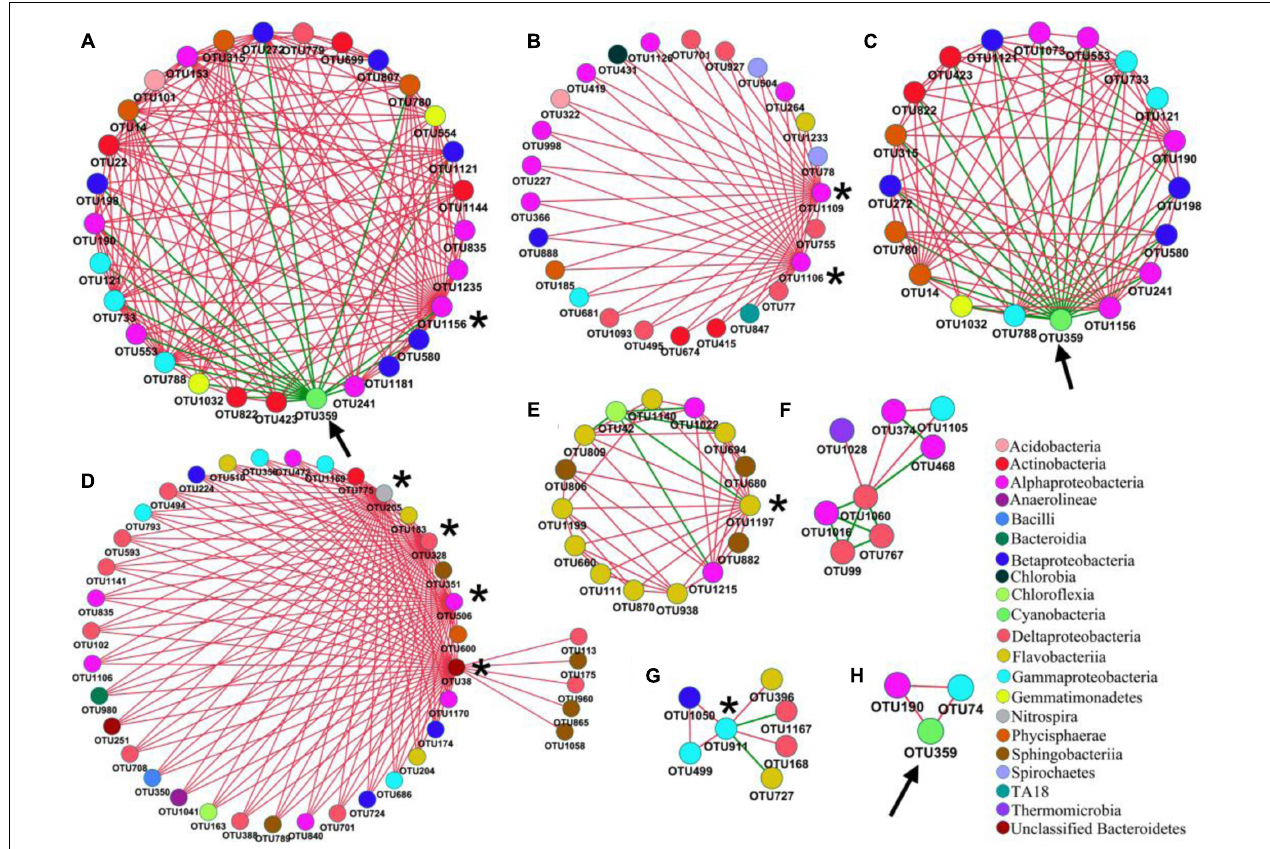
FIGURE 6 | Network interactions between nodes of interest and their nearest neighbors in PAB (A–C) and FLB (D–H) . Interactions of (A,B,D–G) are centered with module hubs (marked with asterisk). Interactions of (C,H) are centered with M. aeruginosa OTU 359 (marked with